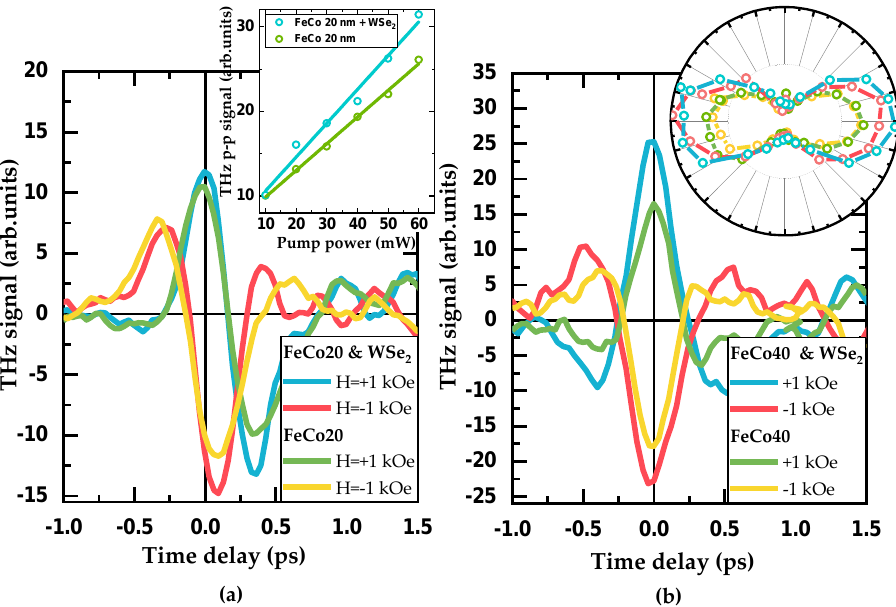
Figure 2. Terahertz emission from bare and WSe 2 − covered FeCo films at opposite directions of the magnetic field: ( a ) FeCo20, ( b ) FeCo40. Insets: ( a ) power dependence and ( b ) polarization dependence of the raw peak − to − peak signal.